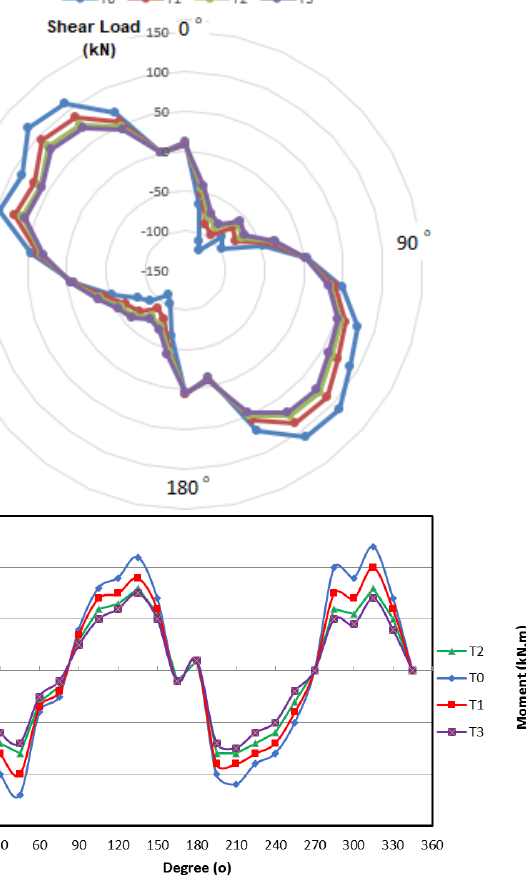
Figure 16: Comparing the shear force in different models Figure 17: Comparing the bending moment in different